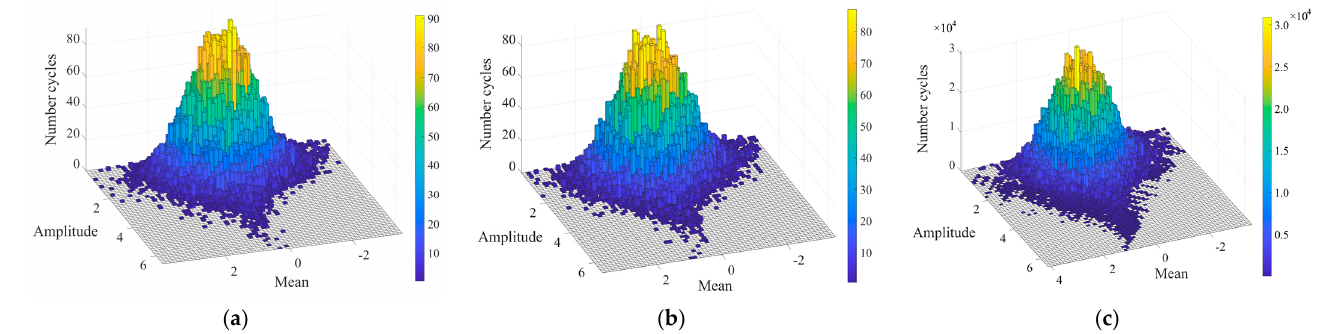
Figure 18. Comparison of rainflow count matrices for load data: ( a ) Original load (after denoising) rainflow matrix, ( b ) Extrapolated 1 ‐ time rainflow matrix, ( c ) Extrapolated full life ‐ cycle rainflow matrix.